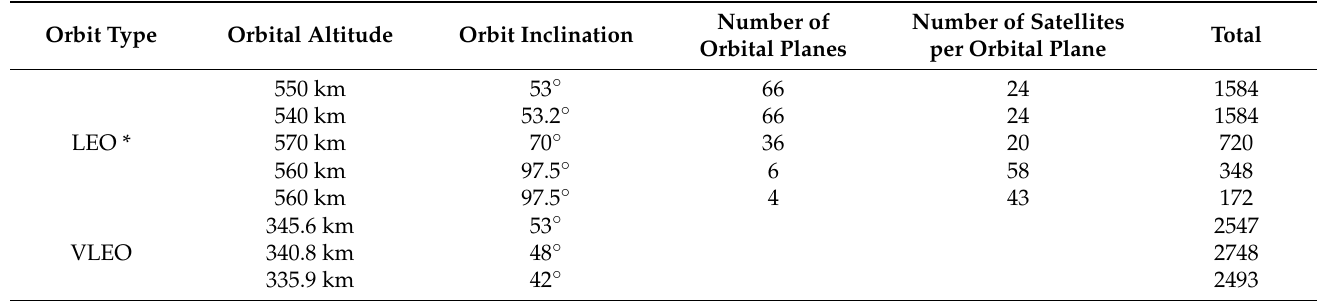
Table 2. Modified Starlink Constellation Phase I